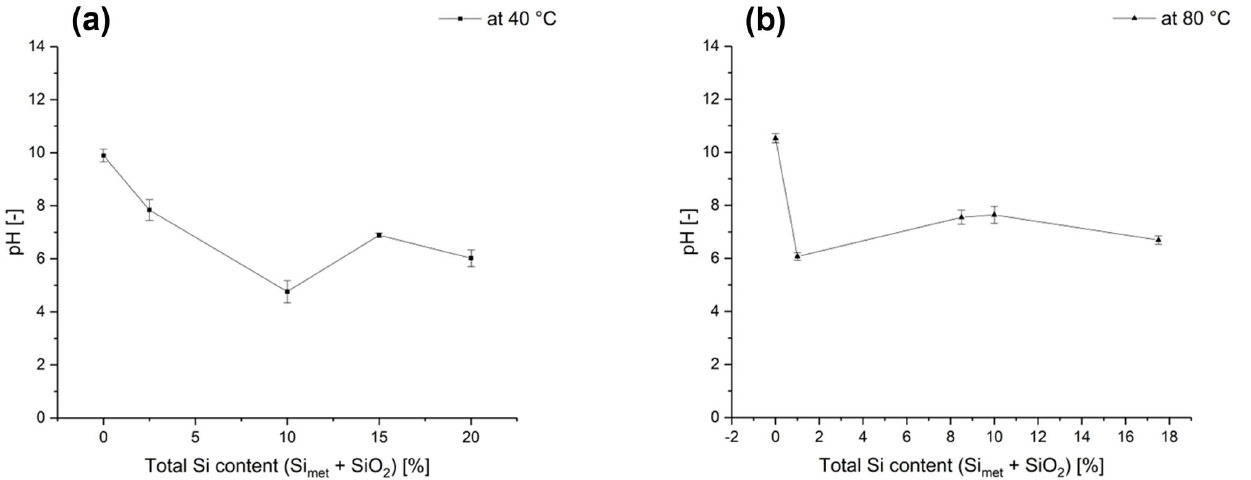
Figure 5. pH of the solutions after the end of leaching (0.5 M H 2 SO 4 ) at ( a ) 40 °C and ( b ) 80 °C as a function of the total amount of silicon (SiO 2 + Si met ) added.